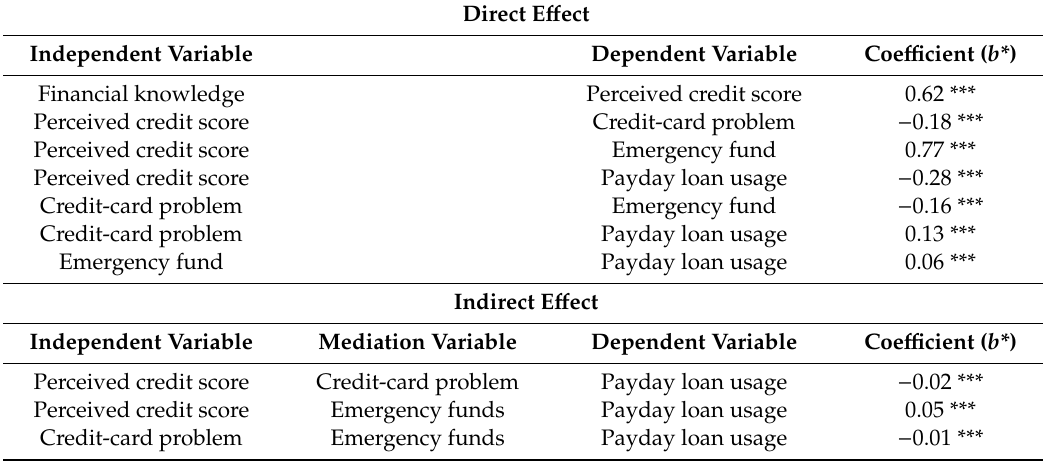
Table 2. Structural equation model (SEM) results of factors related to payday loan usage: direct, indirect, and total e ff